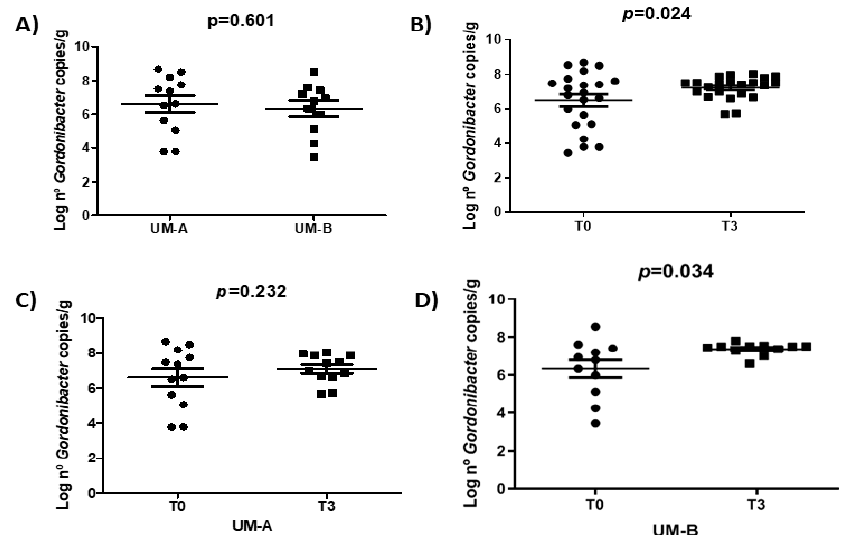
Figure 3. Microbiota composition before (T0) and after the intervention (T3). Gordonibacter levels measured using qPCR according to UMs before the intervention ( A ). Gordonibacter levels before and after the intervention for all the participants ( B ). Gordonibacter levels before and after the intervention for UM-A ( C ) and UM-B participants ( D ). Paired t-test was used to test significance differences in Gordonibacter levels before and after the intervention. Results are presented as mean ± SEM.